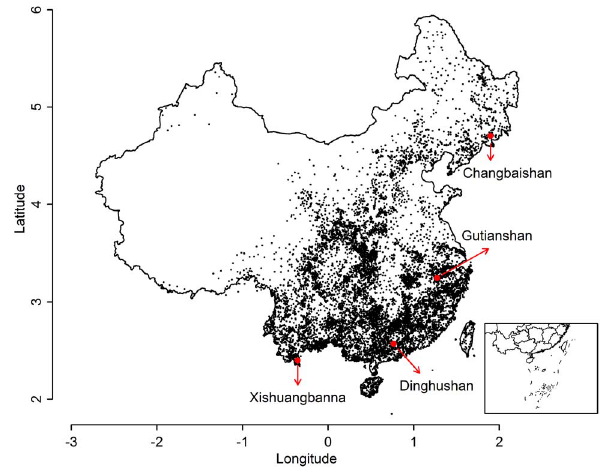
Figure 1. Distribution of geo-referenced records for tree species in China. Included are 461122 records of the 707 tree species occurring in the four marked plots (red dots). Units on the axes are 1000